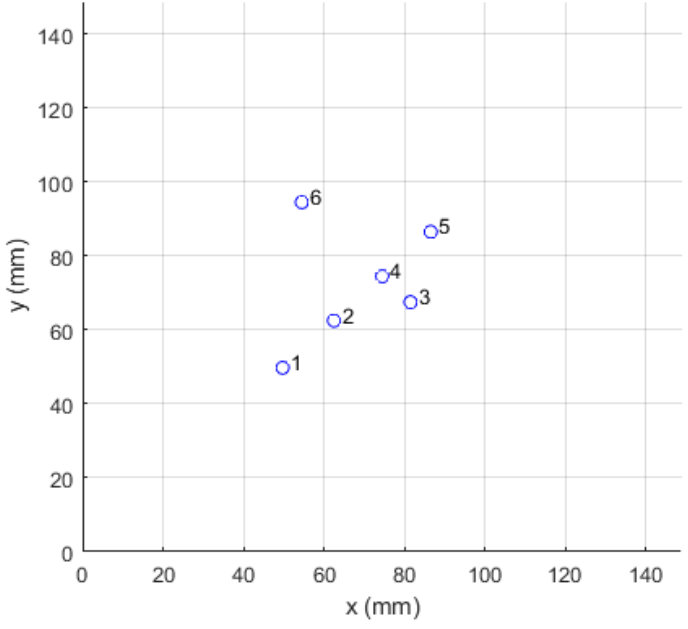
Figure 10. Positions of thermocouples in the plate: top view of the cladded side.